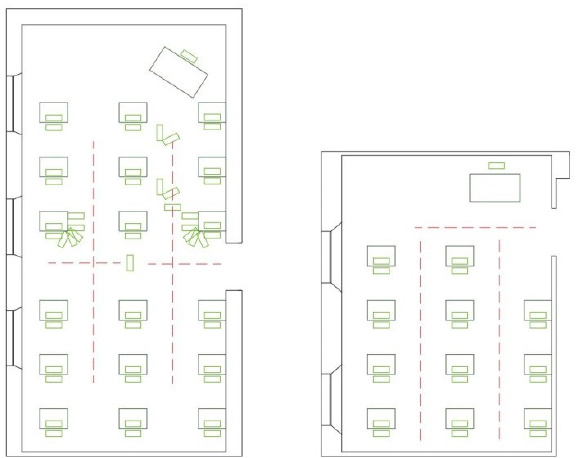
Figure 3. Application of option 2 in classrooms A (left) and B (right)